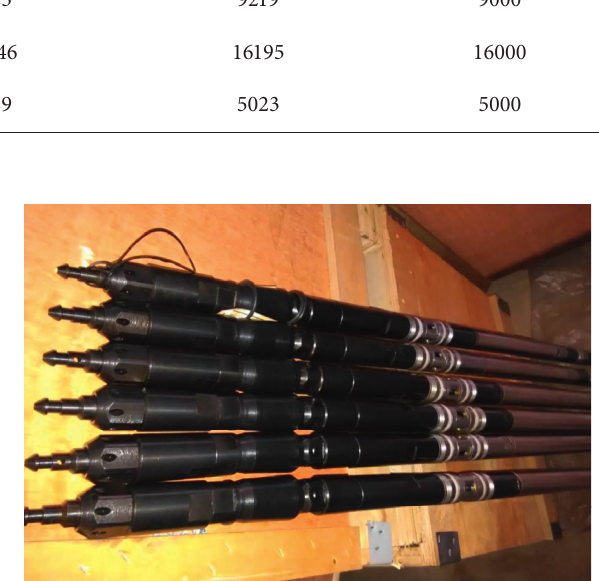
Figure 10: Jet pump core